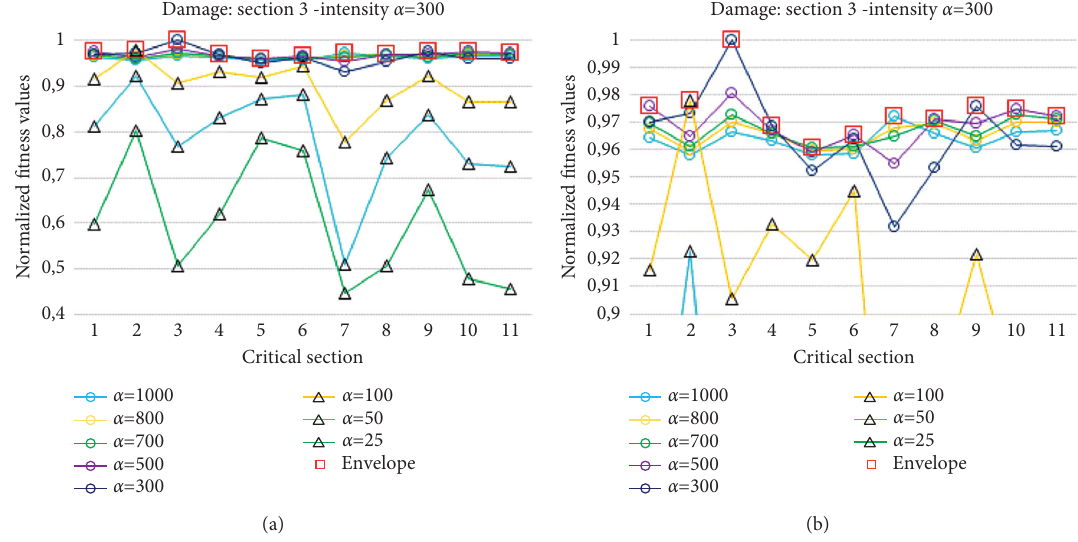
Figure 7: Normalized fitness values for damage with intensity α � 300 located in section 3 (a) and a zoom